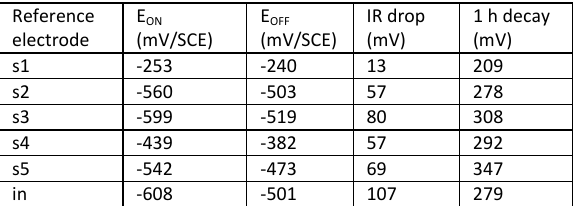
Table 1. Current ‐ On and Instant ‐ Off potentials, ohmic drop and 1 h decay for the different references electrodes. Reference electrode